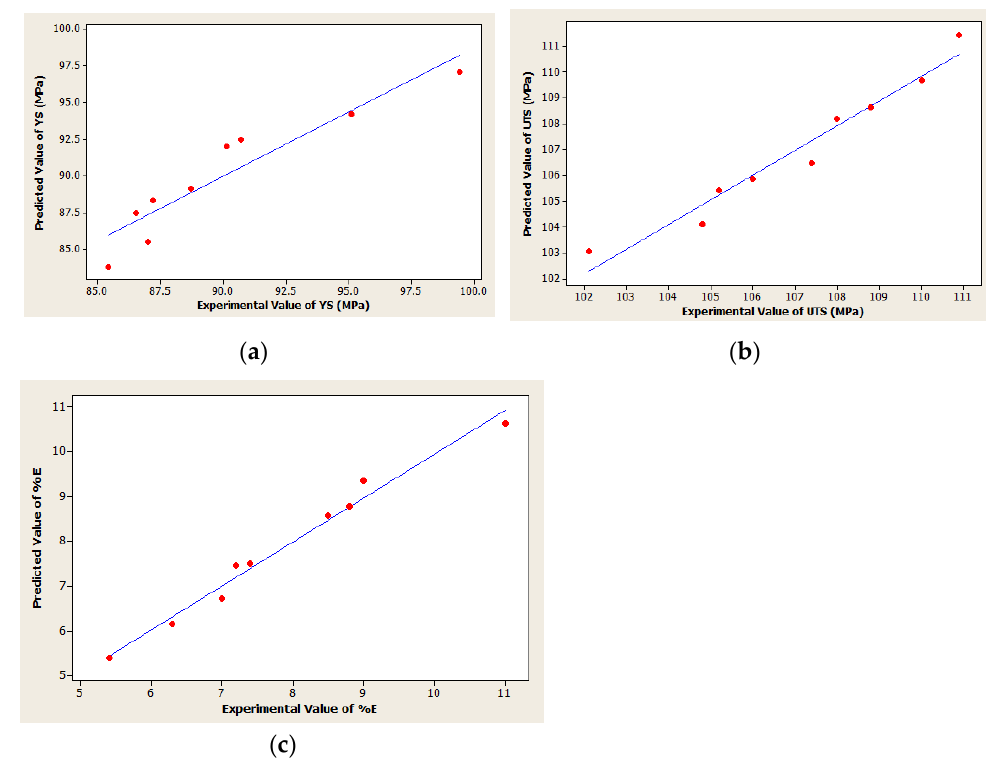
Figure 7. ( a – c ) Scatter diagrams of output responses—tensile properties (YS, UTS, % Figure 7. ( a – c ). Scatter diagrams of output responses—tensile properties (YS, UTS, % E).